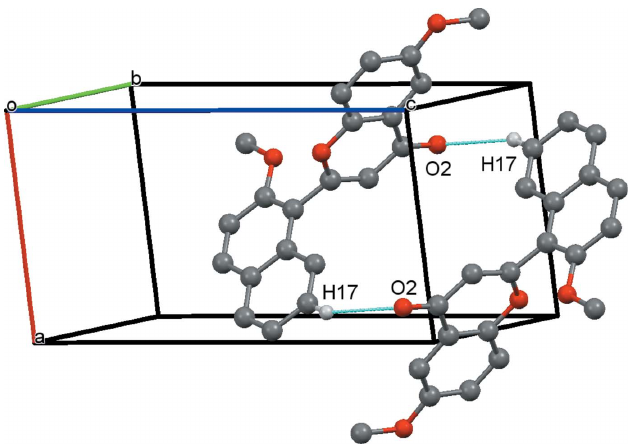
Figure 3 Aview of an inversion dimer formed by pair of C17—H17 (cid:3)(cid:3)(cid:3) O2 hydrogen bonds (dashed lines) in the crystal structure of the title compound. For clarity only those H atoms involved in hydrogen bonding are shown.